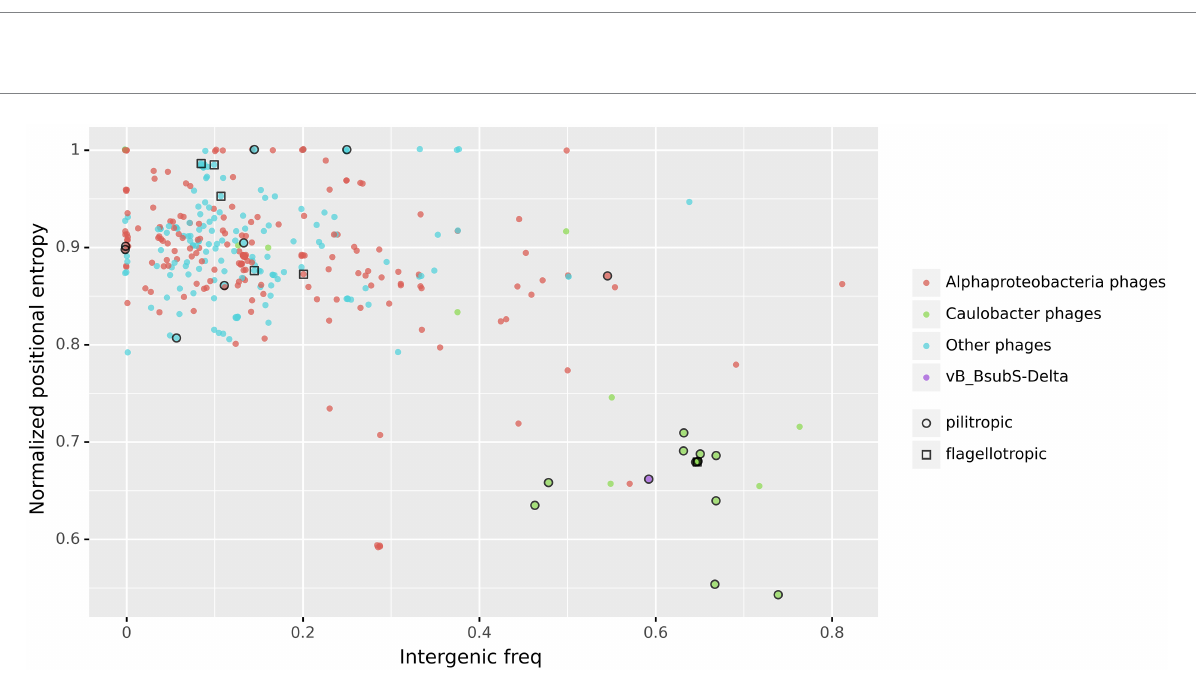
(Supplementary Figure S8). In Rhizobium phage Palo, intergenic CtrA-binding sites are found following its DTR, in the promoter region of genes CPT_Palo_014 and CPT_Palo_015, which have no known function (Supplementary Figure S8). Like